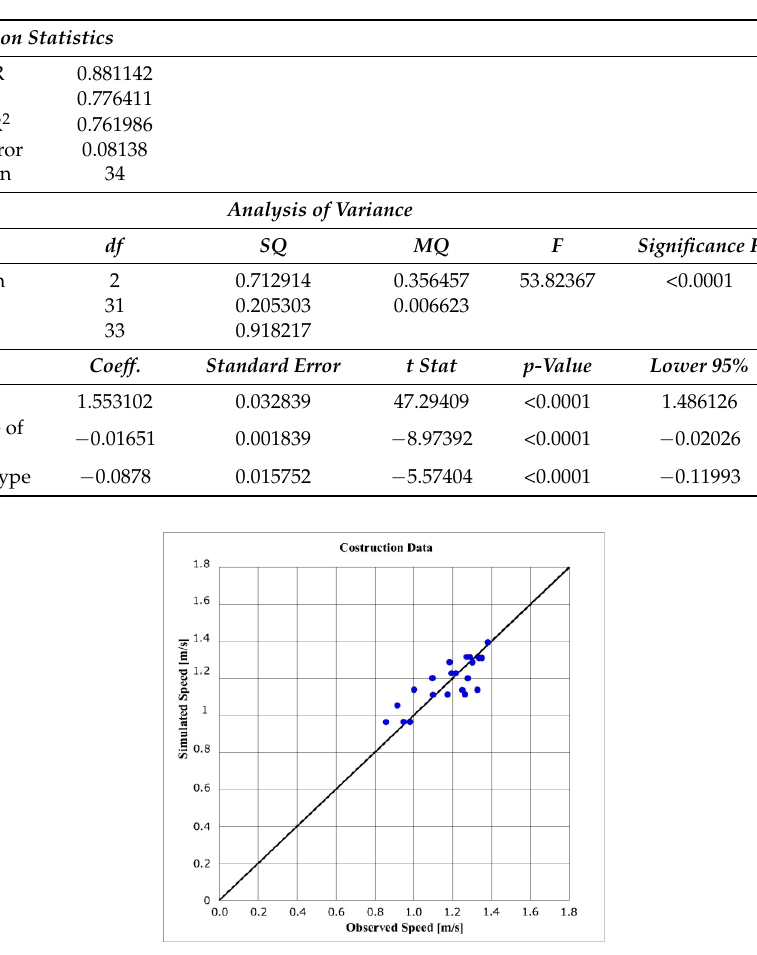
Figure 6. Global Model. Comparison between observed and simulated speeds.